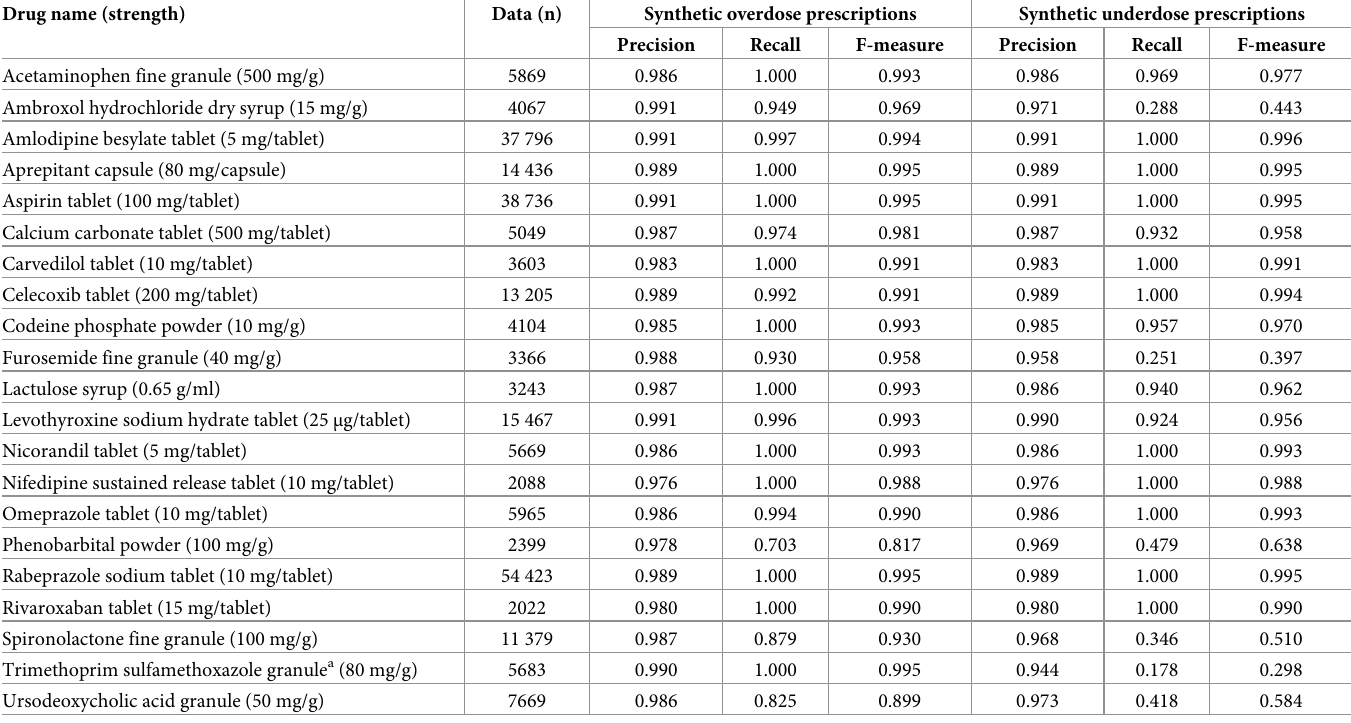
Table 3. OCSVM model performance for detecting synthetic overdose and underdose prescriptions for each